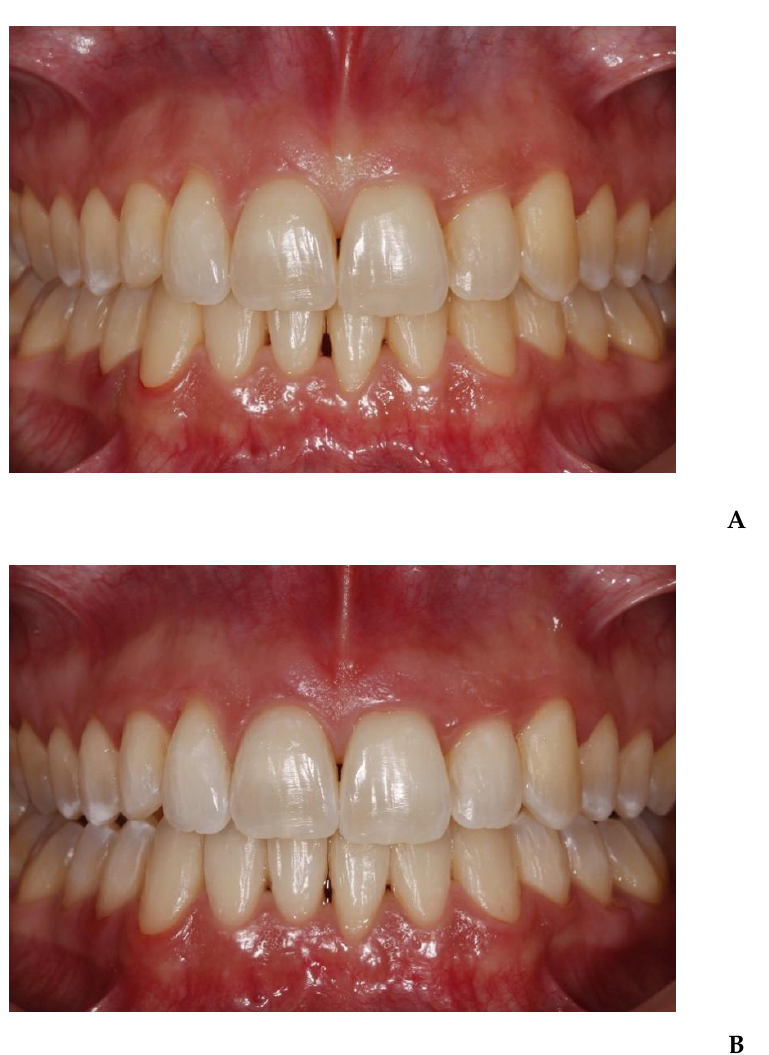
Figure 4. Group 2 patient (37.5% HP, Pola Office + SDI): ( A ) pre-treatment image; ( B ) post-treatment image.